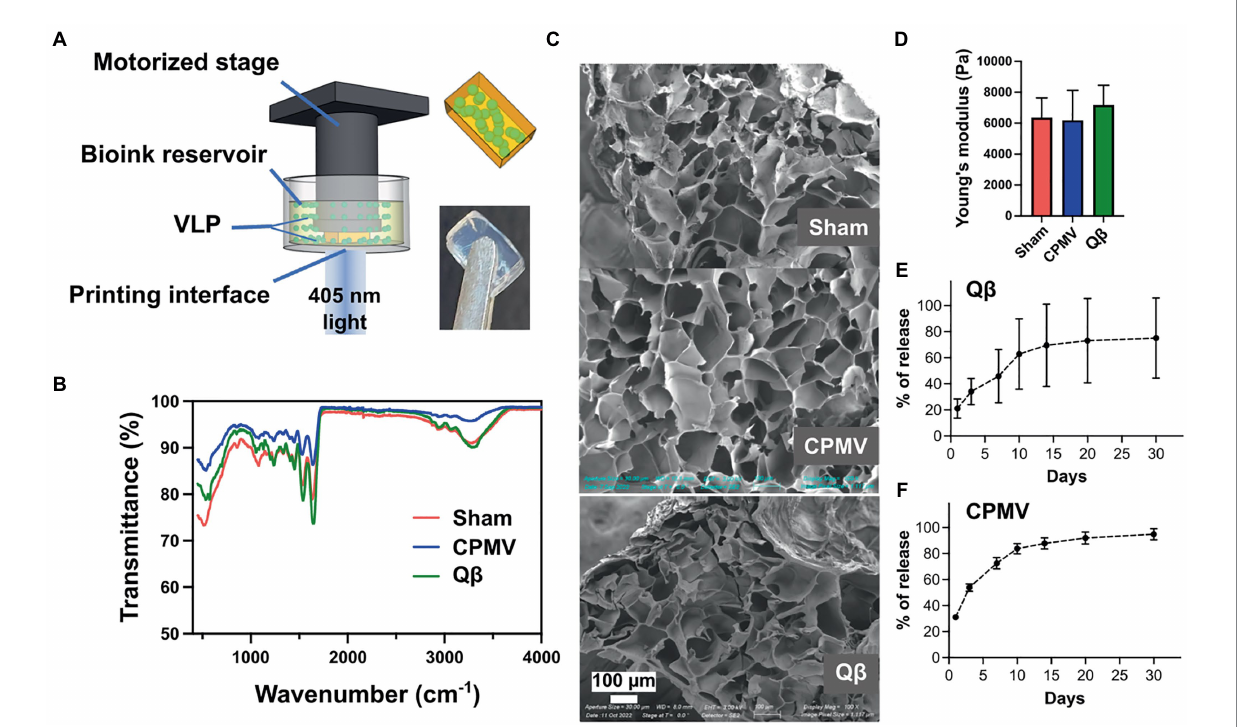
FIGURE 2 Bioprinting and characterization of CPMV and Q β implants. (A) Schematic diagram of the digital light processing (DLP) bioprinting approach. Characterization of empty (sham), CPMV and Q β implants by (B) FITR spectroscopy, (C) SEM and (D) the measurement of Young’s modulus showed no significant differences. Release profiles of printed (E) Q β and (F) CPMV implants in vitro